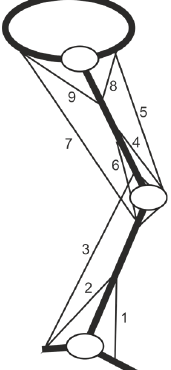
Figure 1. Lower limb muscles that contributes to cycling involved in the